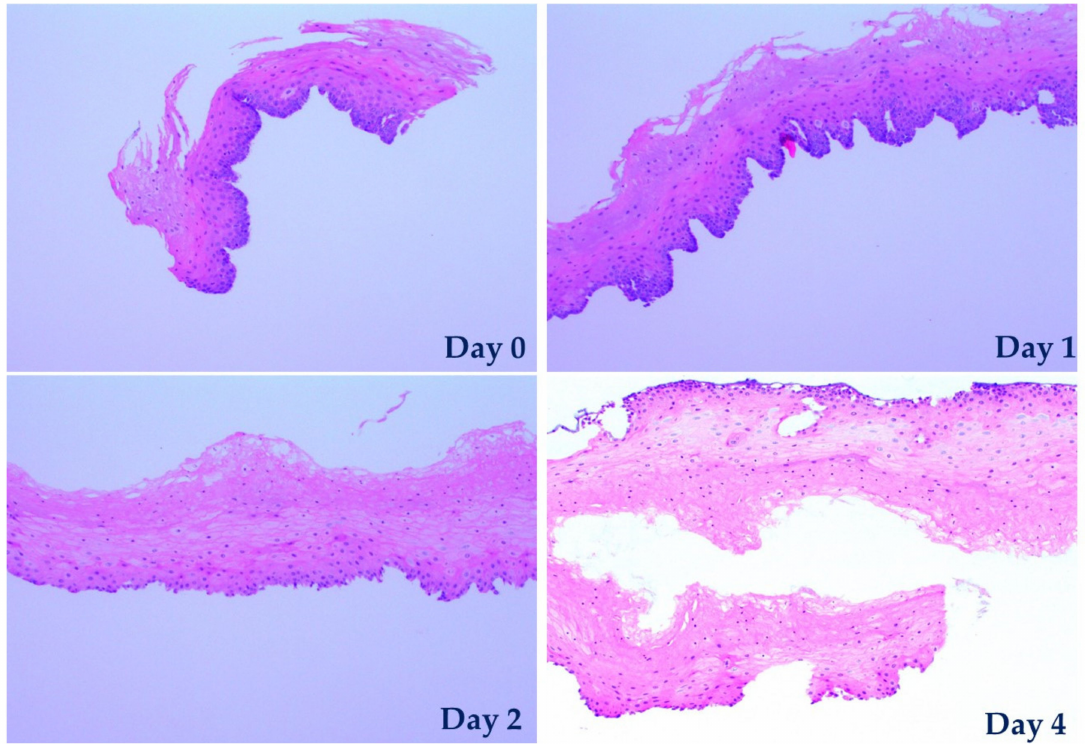
Figure 6. Images of H&E stained tissue specimens in day 0 (before placement in the chip) and after being cultured on-chip for 1, 2 and 4